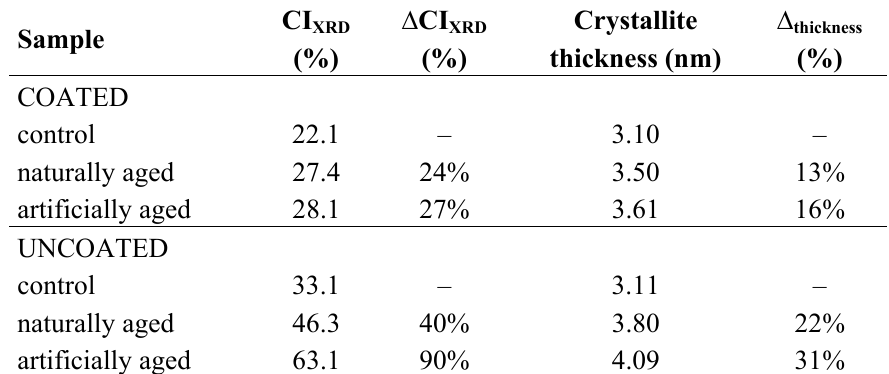
Table 1. Crystallinity index CI measurements on weathered wood.